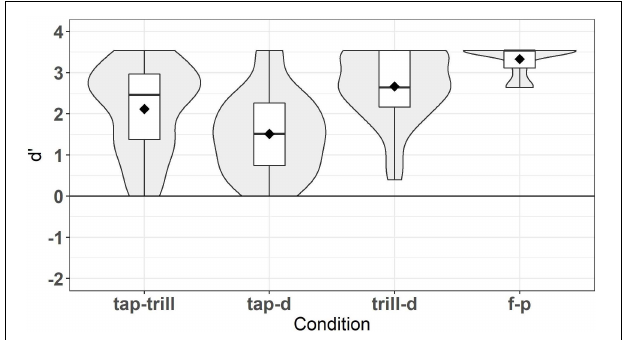
FIGURE 2 | d’ scores for oddity